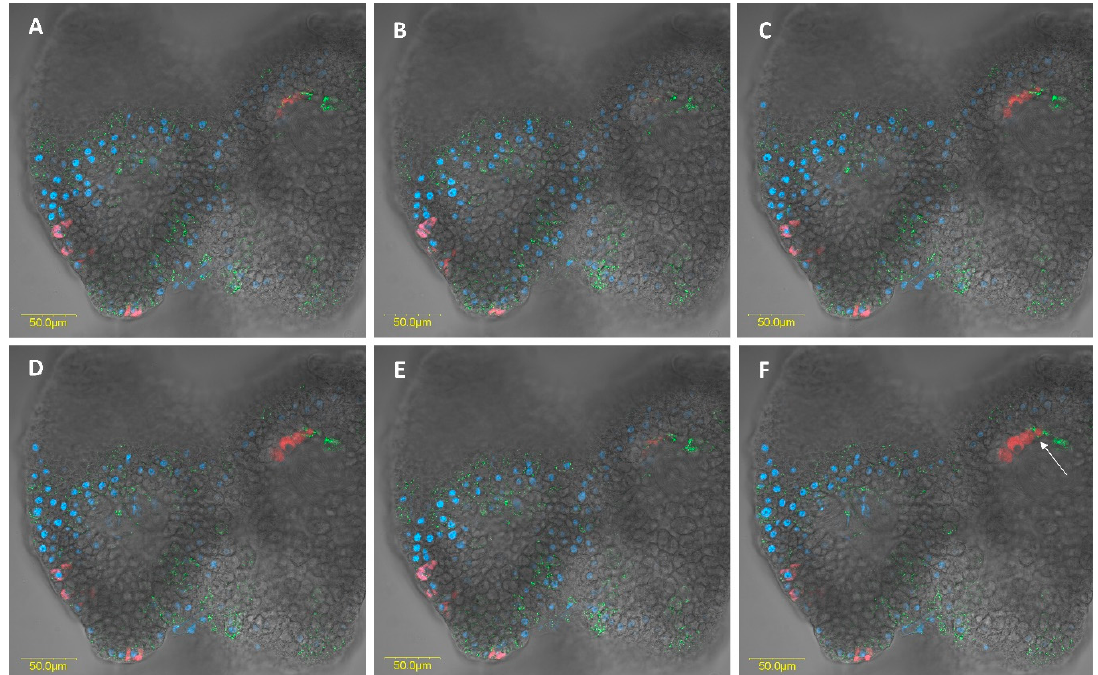
Figure 8. Z sections of two male outgrowth caeca (circle 2 Figure 6C) DNA (blue). R. bellii (red), R. limoniae (green) can be seen to inhabit separate bacteriocytes, as well as occupy the same bacteriocyte in the outgrowth caeca epithelium, e.g., in Figure F, see arrow. A–F Serial Z-sections of 37.7 um (1.3 um increasement).